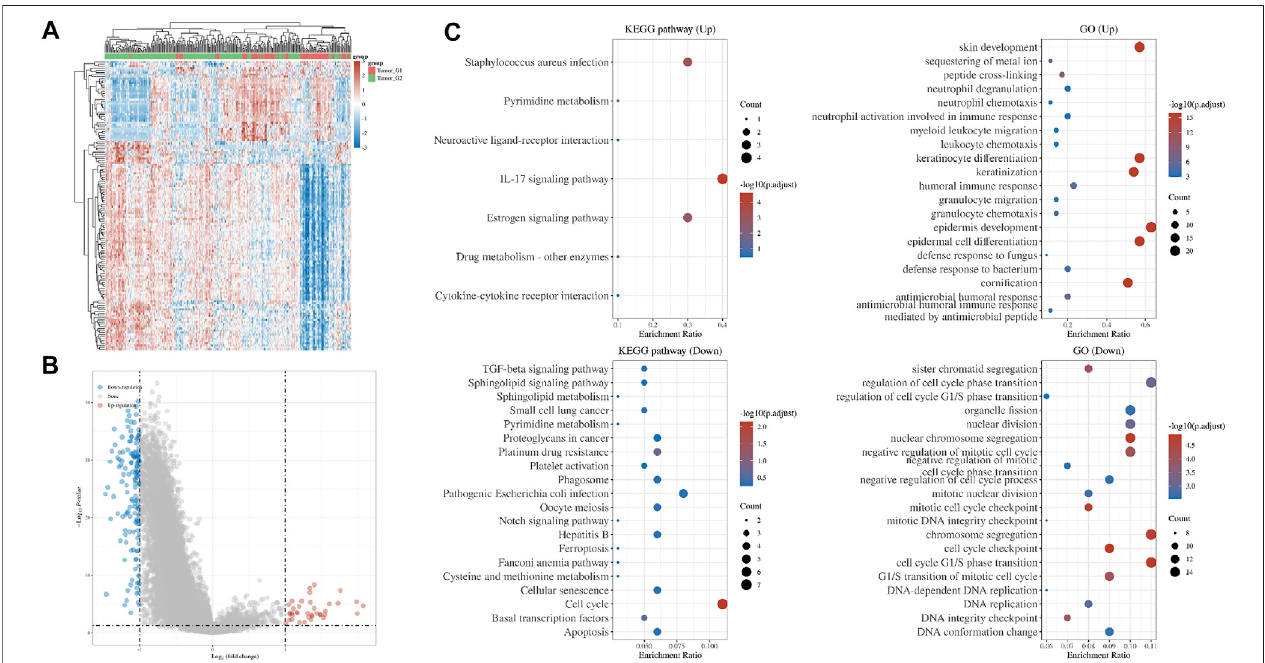
FIGURE 2 | Differences in gene expression between two subgroups. (A) Hierarchical clustering analysis of mRNAs, which were differentially expressed between two subgroups (B) Volcano plot of two subgroups (C) GO and KEGG analysis of two subgroups.